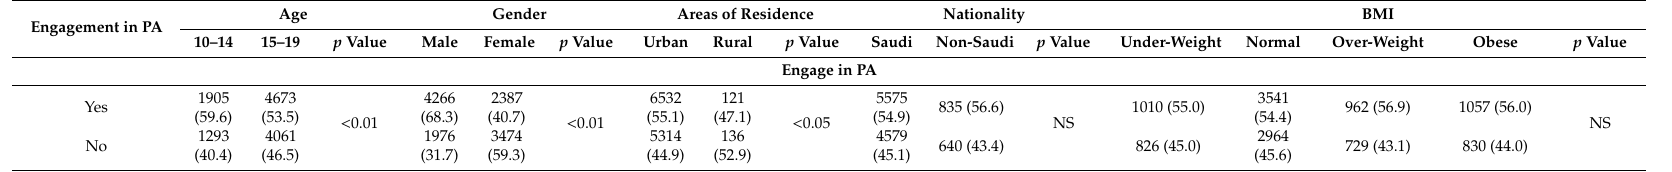
Table 3. Relationship between engaging in physical activity (PA) and demographic characteristics ( n = 12,463).